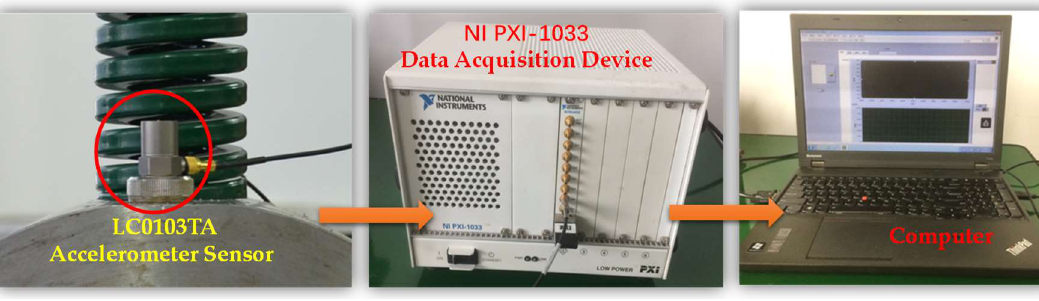
Figure 9. Data acquisition system.